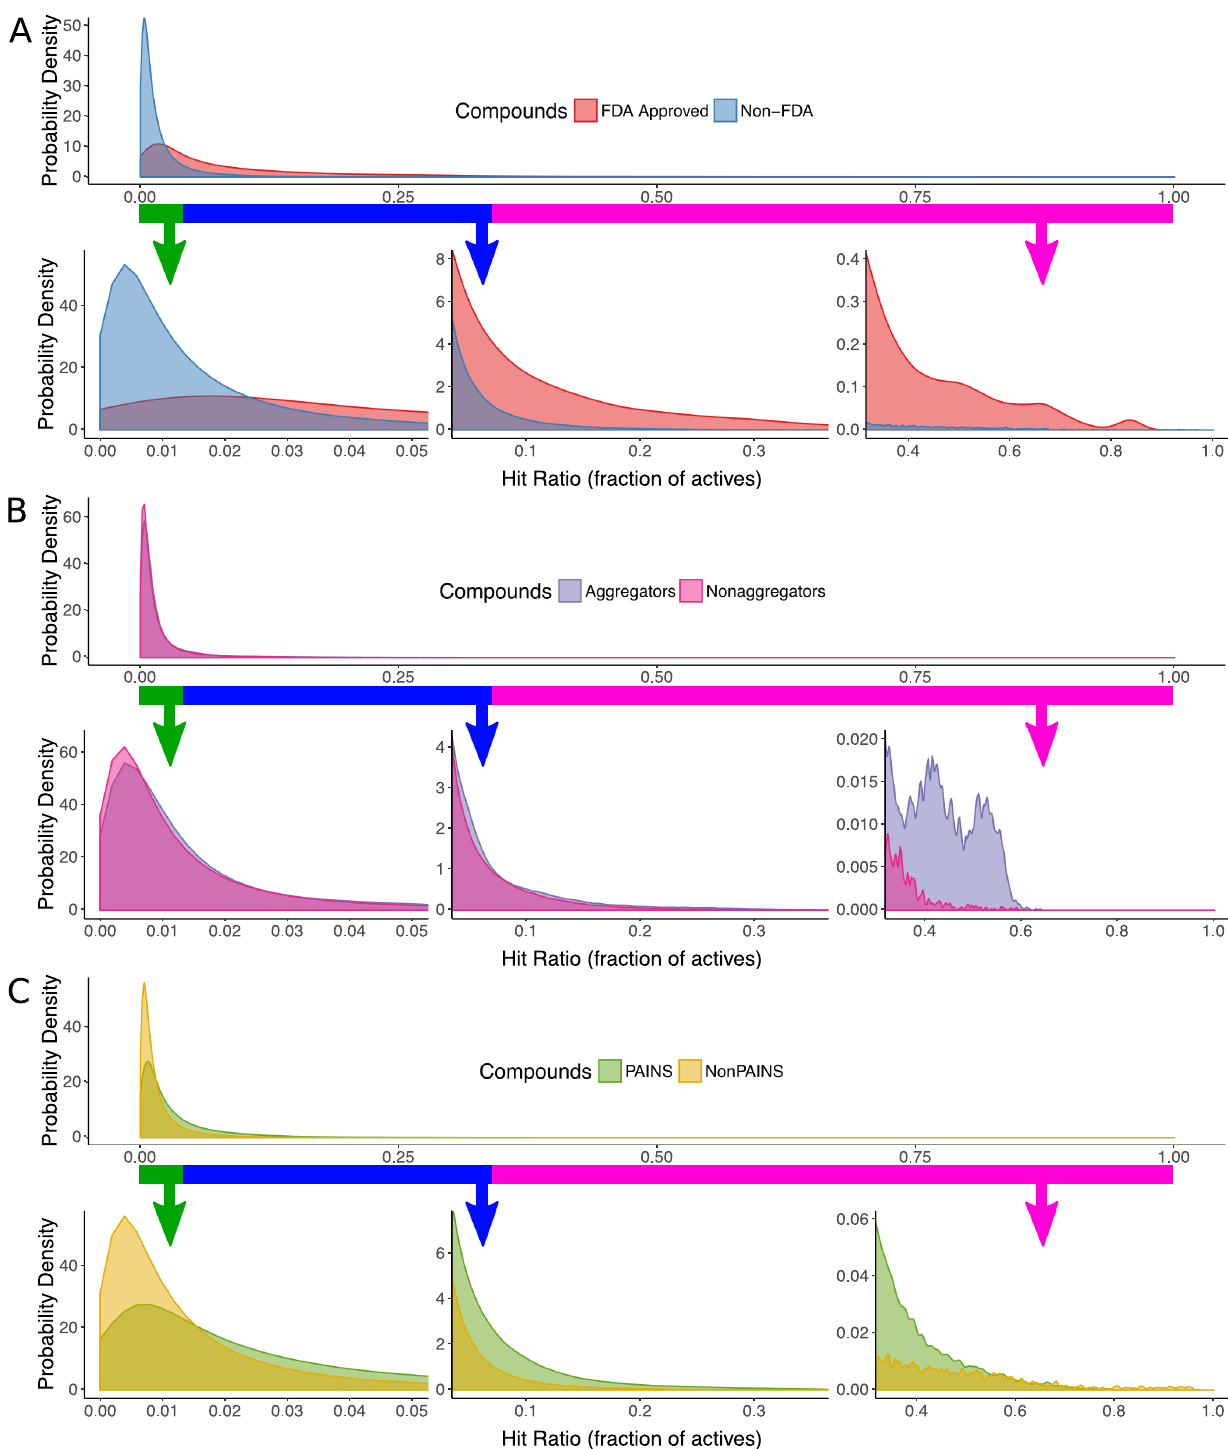
Fig 6. Mixture distribution of hit ratios. The probabilitydensity of hit ratios ( θ ) shown here, is an equallyweightedconvex combination of hit ratio probabilities for individual compounds, which representsthe probabilityof any individualcompoundfrom a set havinga specific hit ratio. Smoothing was appliedto reduce samplingnoise in low probabilityregions.The colored bars highlighta region of each probabilitydistribution, with arrows pointingto a close-up plot of the probabilitydensity in that region. (A) Hit ratio distributions for FDA approvedcompoundsvs non- FDA approvedcompounds. (B) Hit ratio distributions for aggregator compoundsvs non-aggregators. (C) Hit ratio distributionsfor PAINS vs non-PAINS.